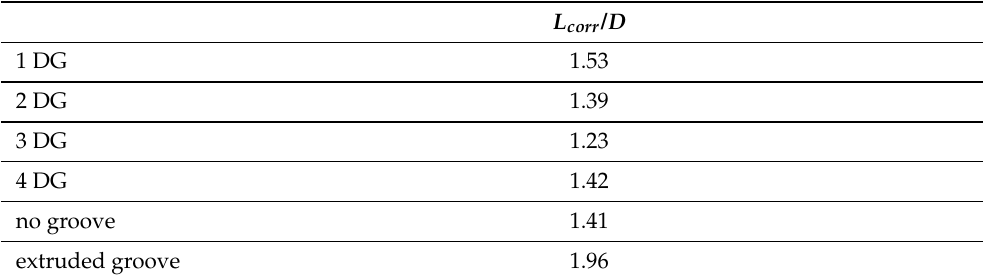
Table 3. Correlation lengths for the spanwise-discontinuous grooves and comparison with the plain boat-tail and the boat-tail with spanwise-extruded groove from